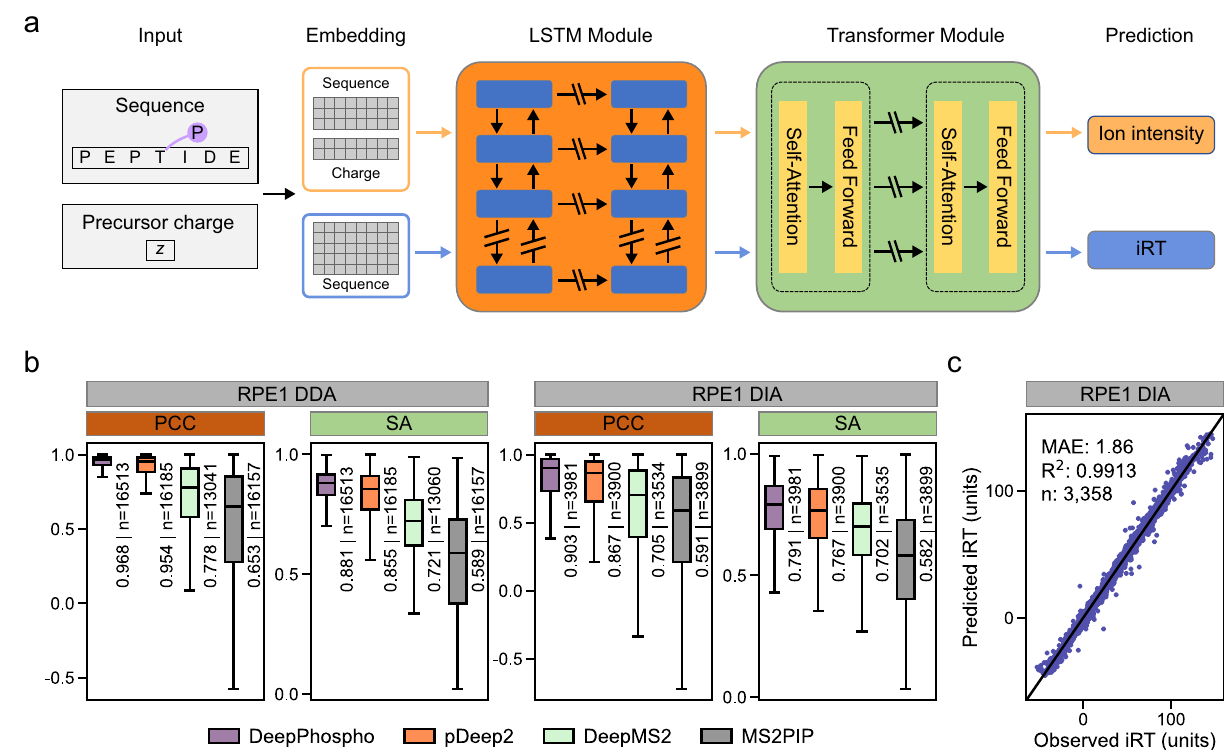
Fig. 1 Model architecture and performance of DeepPhospho. a The DeepPhospho deep learning architecture for indexed retention time (iRT) and fragment ion intensity prediction for any given phosphopeptide. Given a peptide sequence and the precursor charge as input, our model fi rst uses a bi-LSTM network to compute an initial representation of all the amino acids, which are then re fi ned by a Transformer module. The resulting global features are fed into a linear regressor network to generate predictions for fragment ion intensity and iRT. b Evaluation of DeepPhospho and three other models based on the distribution of Pearson correlation coef fi cient (PCC) and spectral contrast angle (SA) calculated between predicted and experimental MSMS spectra from two datasets. Median PCC and SA are indicated; n is the number of phosphopeptides in the test set. Boxplot center line, median; box limits, upper and lower quartiles; whiskers, 1.5× interquartile range. c Evaluation of DeepPhospho based on the correlation of predicted and experimental iRT values. Correlation coef fi cient of linear regression ( R 2 ) and median absolute error (MAE) are indicated. Source data for this fi gure are provided as a Source data fi